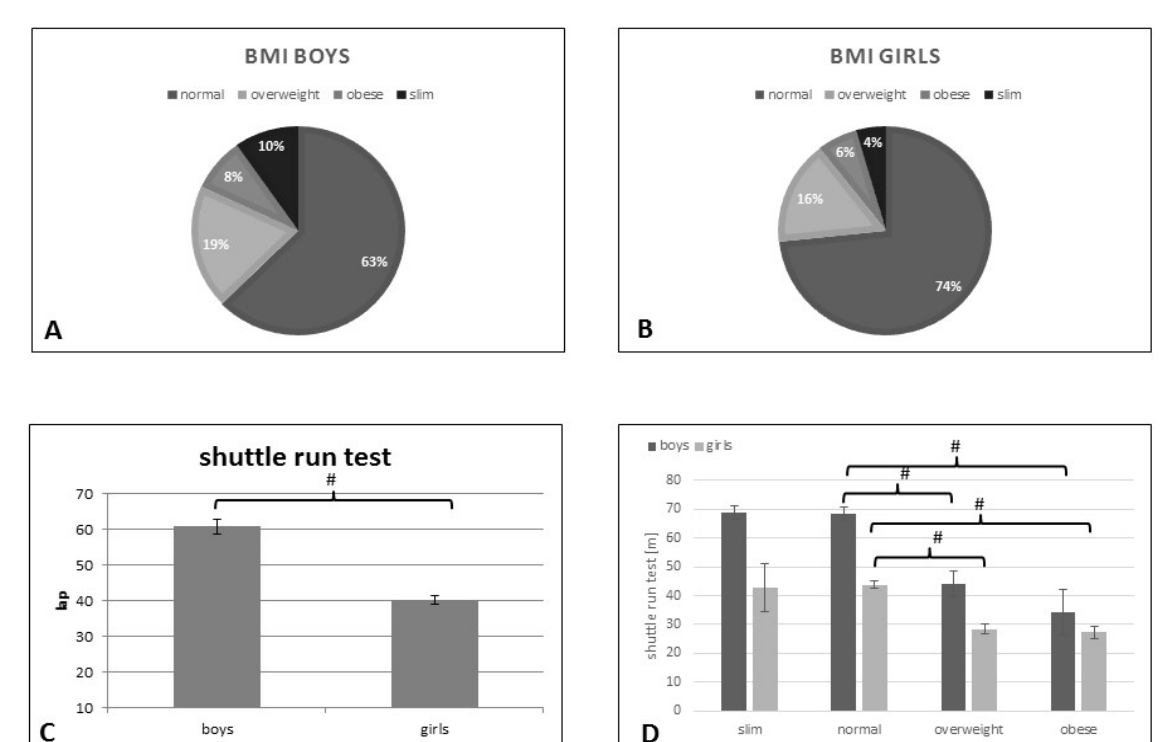
Figure 1. BMI-for-age in boys ( A ) and girls ( B ). Our results depicted significant differences in gender specific ( C ) and BMI- for-age specific shuttle run test ( D ) (data are shown as mean ± S.E.M, # = p < 0.001).